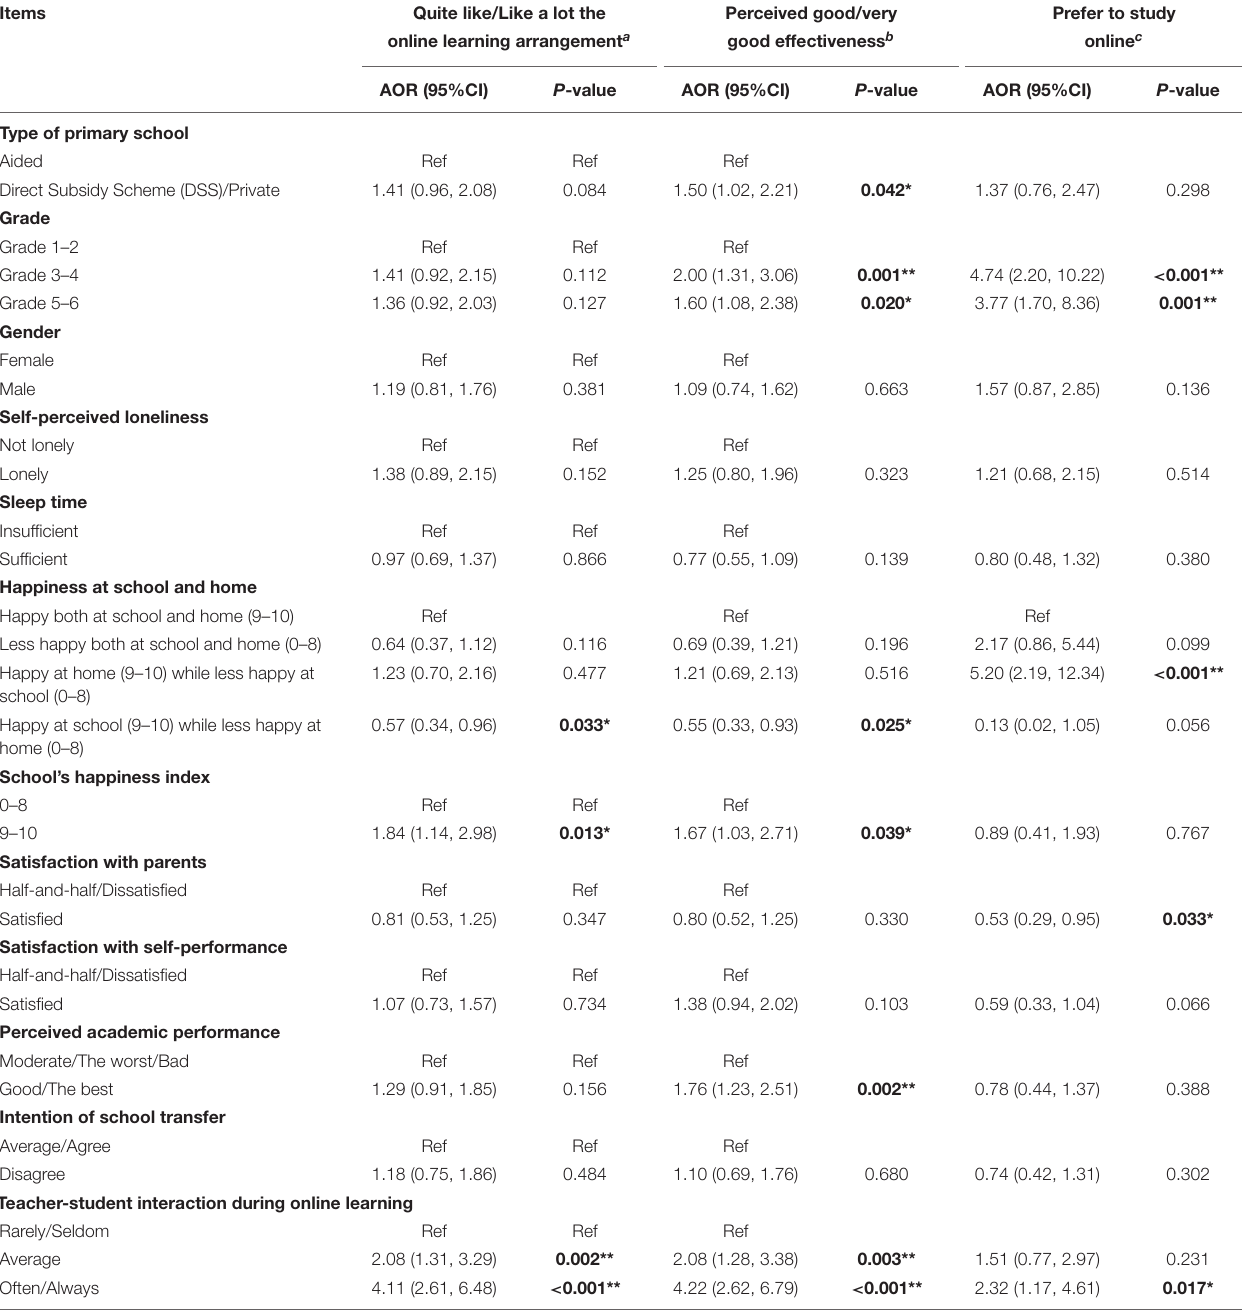
TABLE 3 | Multiple regression results of factors associated with Students’ views on online learning. Items Quite like/Like a lot the Perceived good/very Prefer to